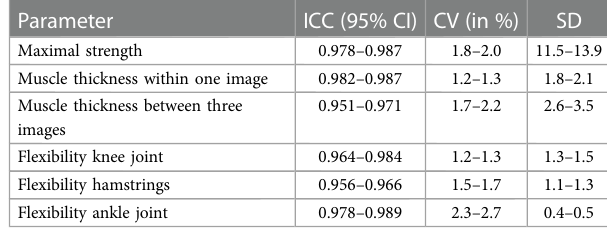
Maximal strength and muscle thickness Comparisons of mean values of isometric MSt and MTh in pre- and post-tests for both groups and each leg and the results of ANOVA are presented in Table 3 .